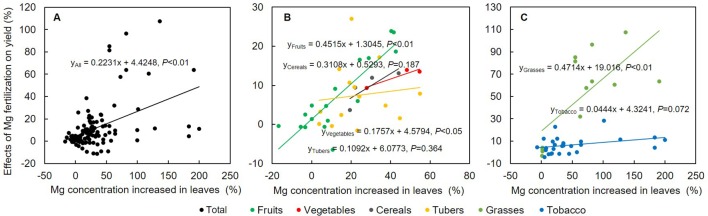
The relationship between effects of Mg fertilization on yield and variations in Mg concentrations in all crops (A), vegetables, tubers, fruits, cereals (B), grasses and tobacco (C). Individual crop was represented by colored circle, and the response relation is fitted by a straight line of the same color line. P-value, indicated the significance of the results.